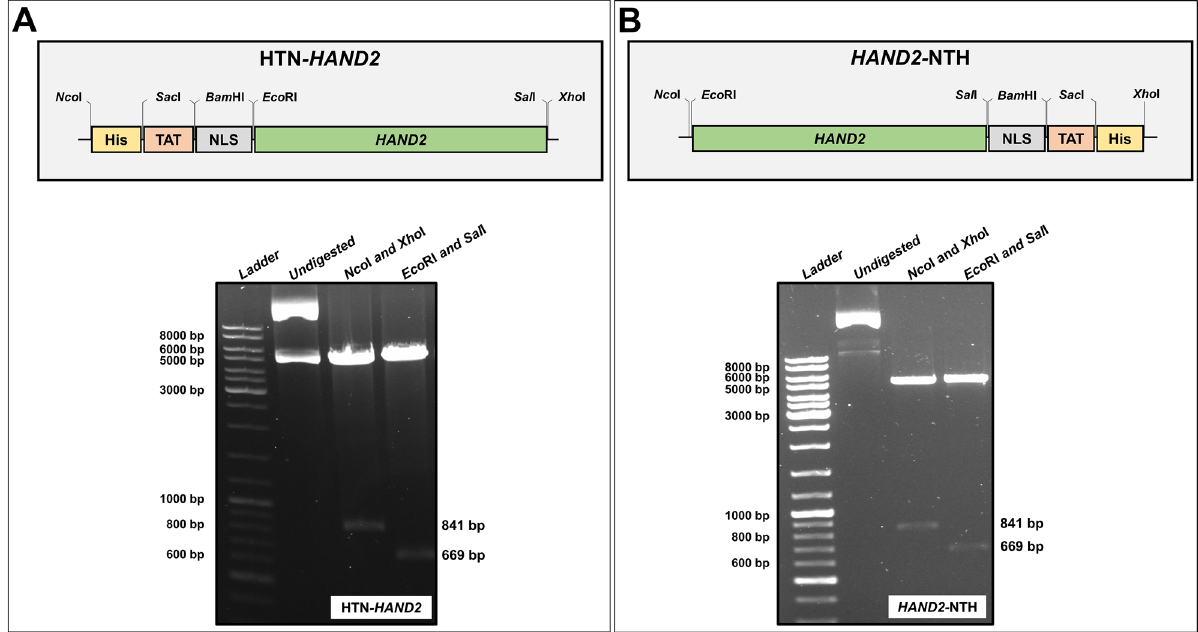
Figure 1. Schematic illustration of the tagging pattern in the human HAND2 gene and verification of cloning. (A) An Illustration of HTN- HAND2 ( top ) gene insert (not drawn to scale) and verification of the cloned plasmid pET28a(+)-HTN- HAND2 ( bottom ) using restriction digestion analysis. ( B) Illustration of HAND2 -NTH ( top ) gene insert (not drawn to scale) and verification of the cloned plasmid pET28(+)- HAND2 -NTH ( bottom ) using restriction digestion analysis. His (H): polyhistidine (8X); TAT (T): Transactivator of Transcription; NLS (N): Nuclear Localization Sequence/Signal. The uncropped gels are presented in Supplementary Figs. S6 and